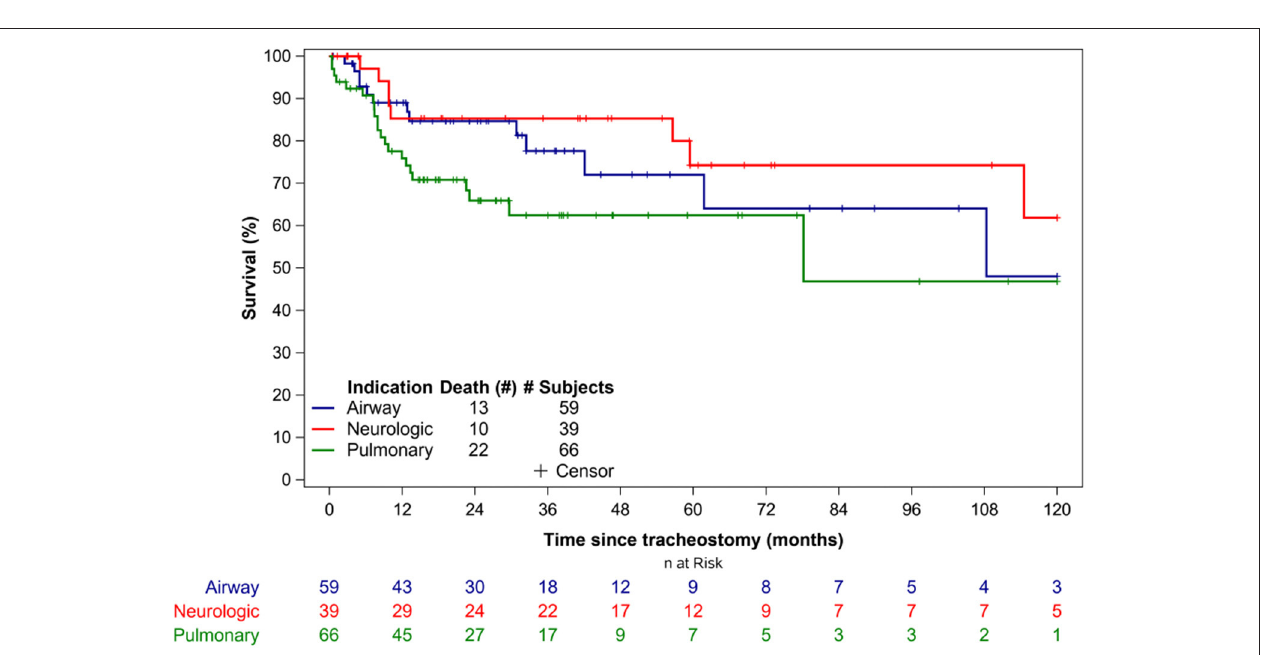
FIGURE 2 | Survival estimates based on the indication for